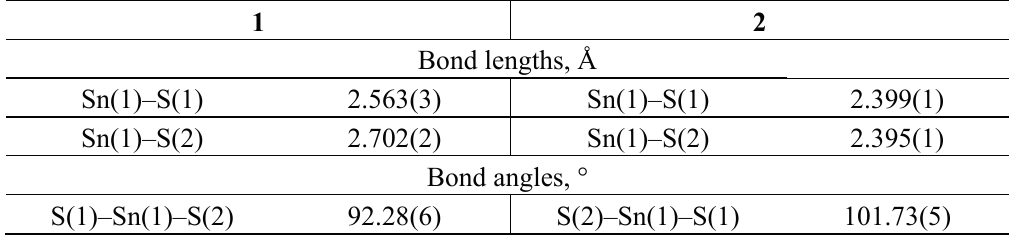
Table 2. Selected bond distance and bond angles for compounds 1 and 2